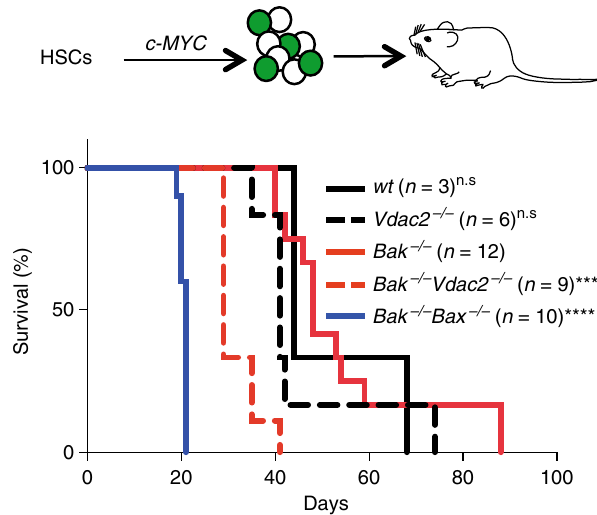
Fig. 6 VDAC2 enables BAX to limit tumor development. Vdac2 deletion accelerates the development of MYC -driven AML. Kaplan – Meier survival plot of mice transplanted with wild-type (wt), Vdac2 − / − , Bak − / − , Bak − / − Bax − / − or Bak − / − Vdac2 − / − fetal liver-derived hematopoietic stem cells (HSCs) (2 livers per genotype, see Supplementary Figure 7a) infected with a c-MYC – expressing retrovirus. P values (Log-rank analysis) of mice injected with Bak − / − hematopoietic precursors compared with Bak − / − Vdac2 − / − or Bak − / − Bax − / − precursors are <0.001 (***) and <0.0001 (****) respectively. n.s, not signi fi